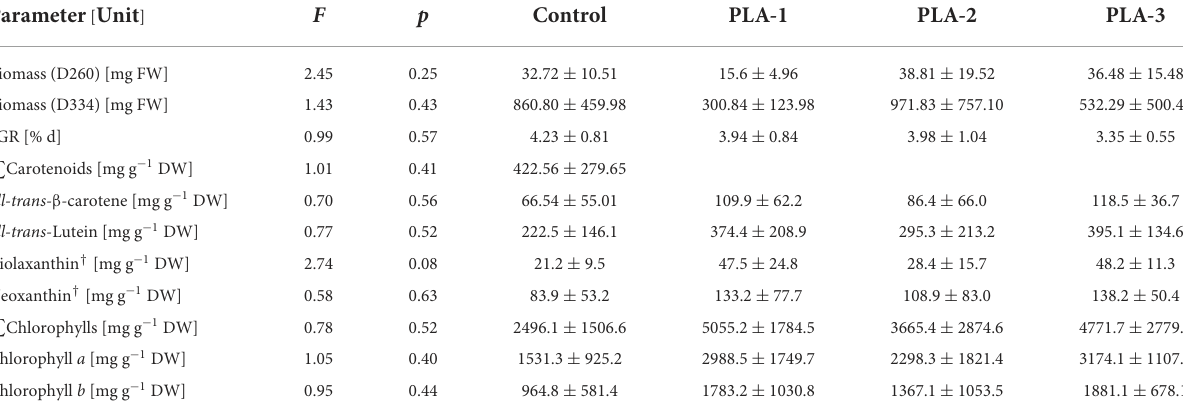
TABLE 4 Differences in biomass, specific growth rates (SGRs), carotenoid and chlorophyll concentrations of Ulva fenestrata grown exposed to different PLA materials (types 1–3) under a 10h photoperiod with artificial LED illumination (75 µ mol m ² s − 1 PPFD) at 18 ◦ C in artificial seawater (tropic marine) at 2.9 % salinity.